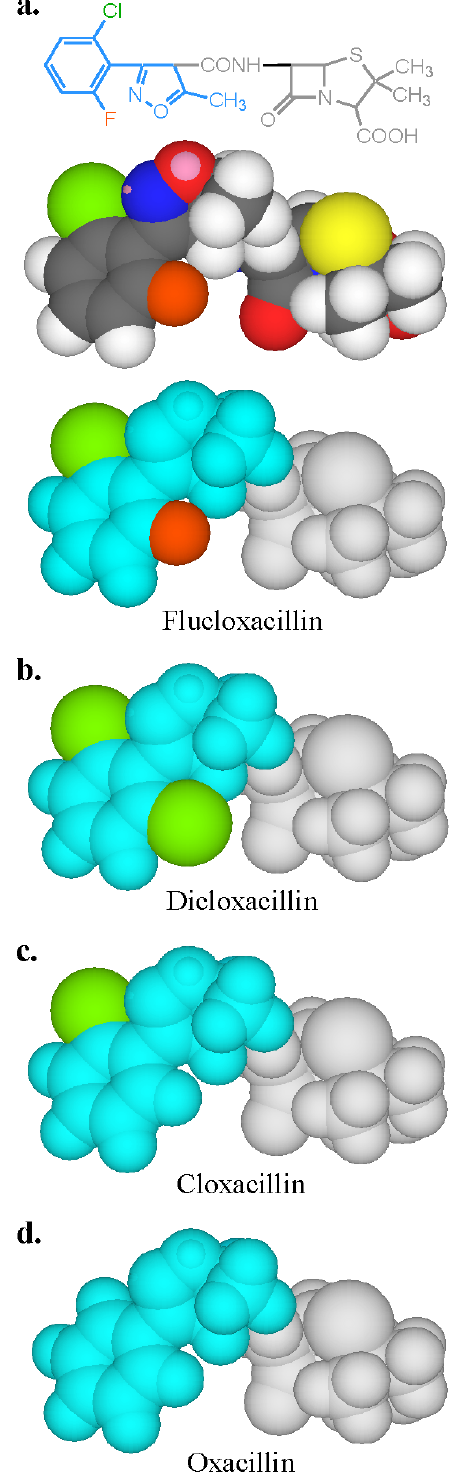
Figure 6. Two- and three-dimensional structure and models of flucloxacillin and three-dimensional models of dicloxacillin, cloxacillin and oxacillin showing the IgE antibody-binding regions (colored blue, green and orange) on the isoxazolyl penicillins. Chlorine atom is green, fluorine,